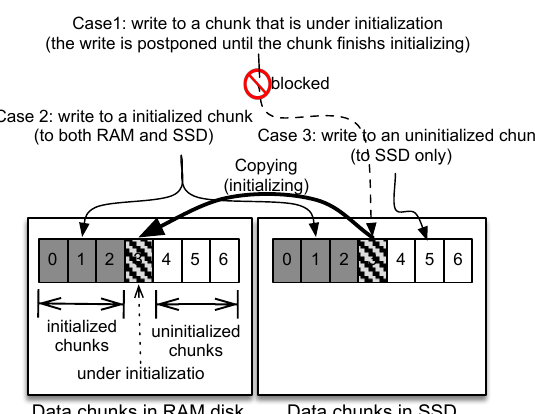
Figure 4. Three write cases during initialization. DHRD ensures data integrity with proper policy for each